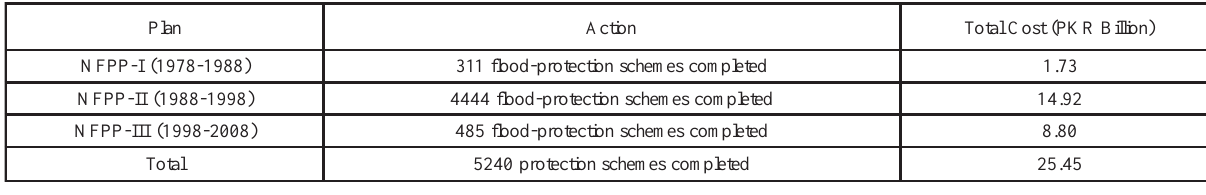
TABLE 4. AN OVERVIEW OF NATIONAL FLOOD PROTECTION PLANS